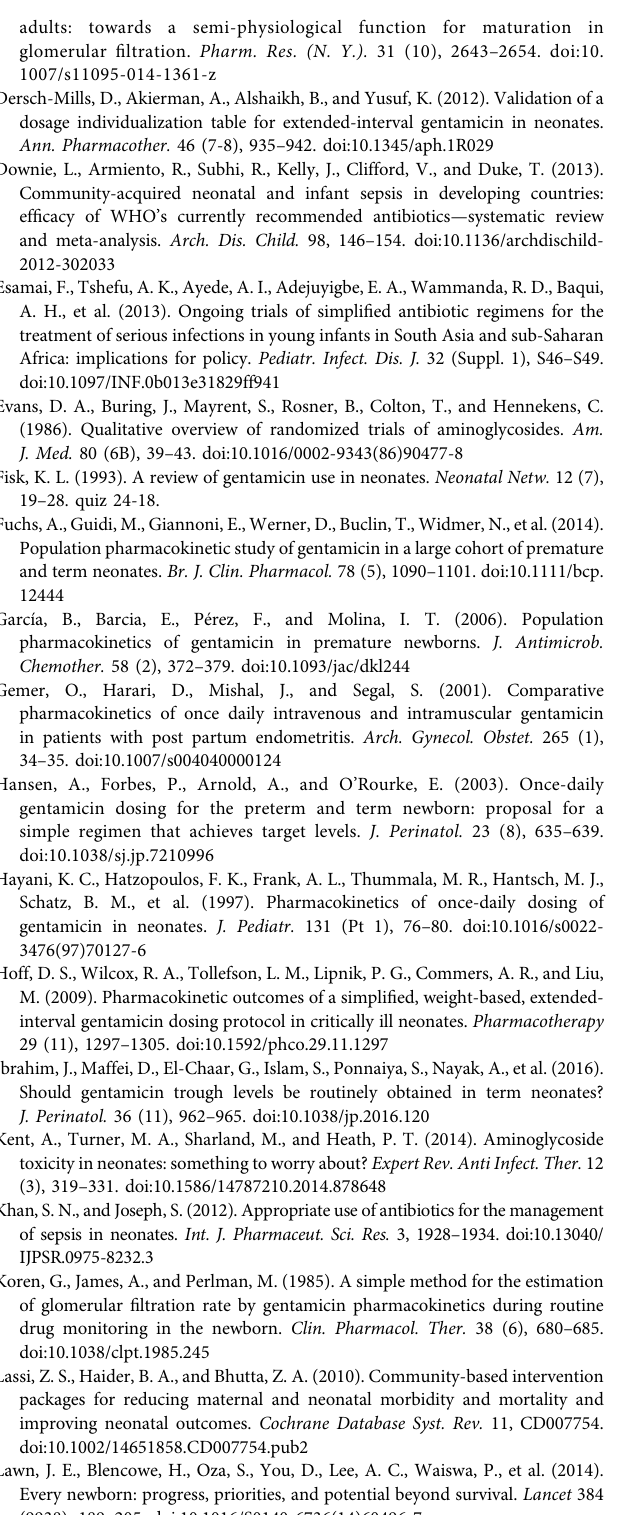
adults: towards a semi-physiological function for maturation in glomerular fi ltration. Pharm. Res. (N. Y.). 31 (10), 2643 – 2654.